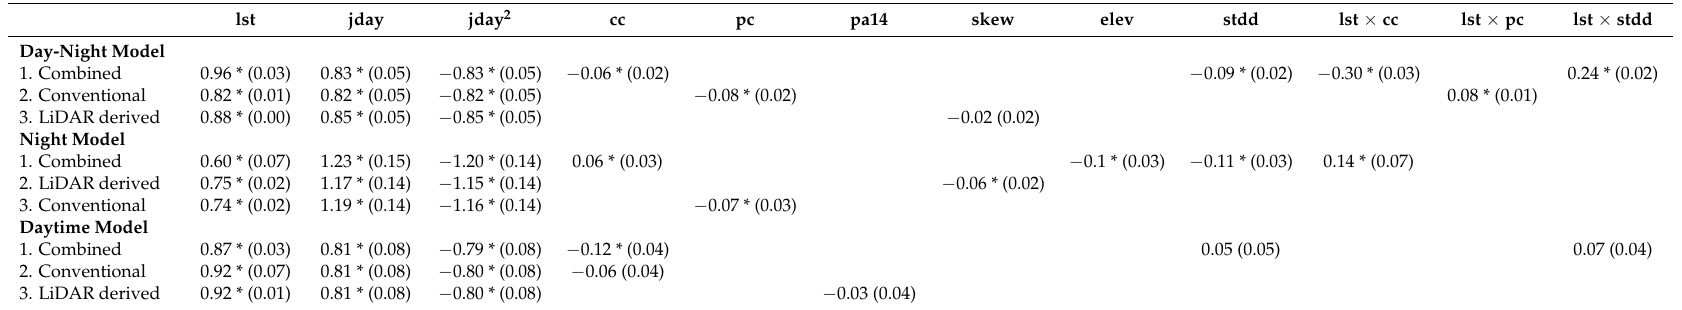
Table 5. Estimated parameters for the top-ranked models from each overpass dataset. Standardized coefficients and standard errors (in parentheses) are presented by model. lst jday jday 2 cc pc pa14 skew lst × stdd Day-Night Model 1.